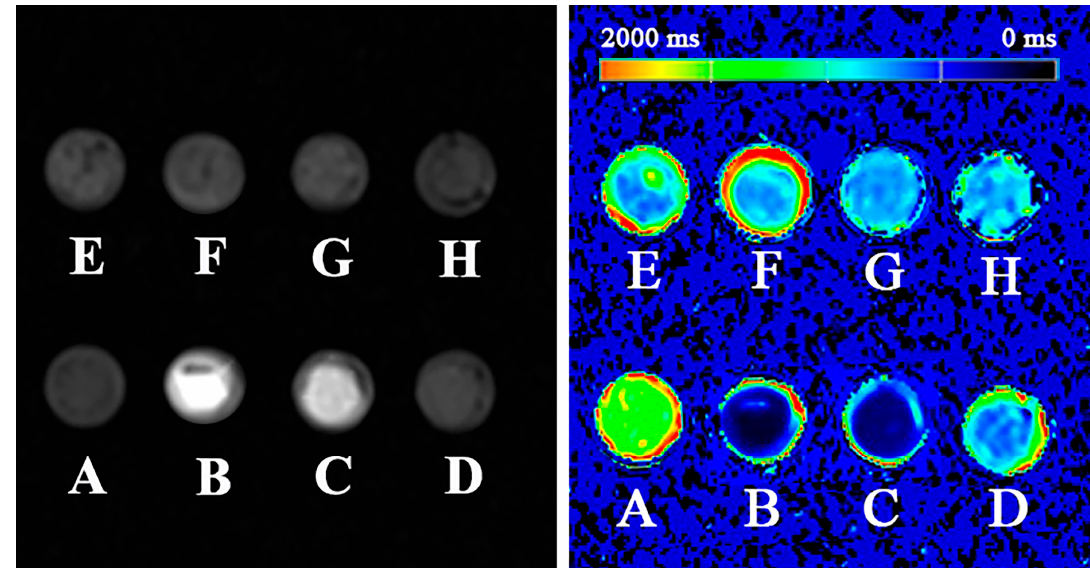
Figure 9. T 1 -weighted imaging ( left ) and T 1 -parametric mapping ( right ) images of PLGA (A), GdPO 4 ·H 2 O/PLGA (B), GdPO 4 ·H 2 O@SiO 2 /PLGA (C), GdPO 4 ‧ H 2 O@SiO 2 –APS/PLGA (D) and PBLG-g-GdPO 4 ·H 2 O/PLGA with grafting rates of 4.14% (E), 5.93% (F), 13.72% (G) and 15.93% (H).